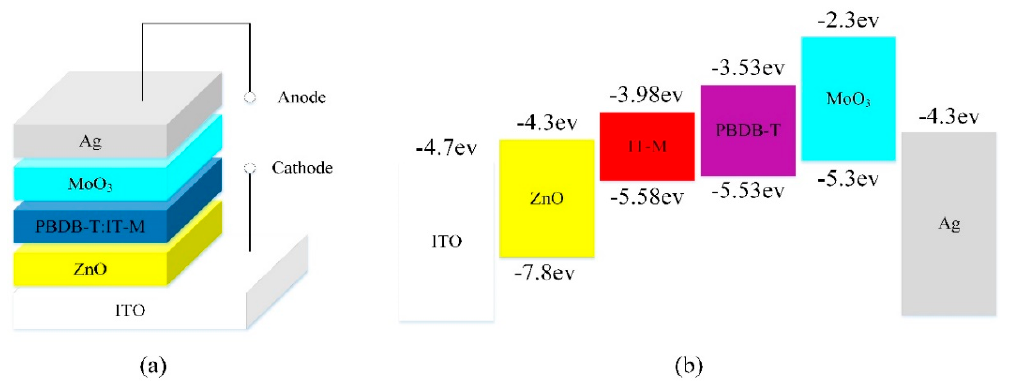
Figure 1. ( a ) Schematic device structures of inverted organic solar cells (OSCs); ( b ) energy level alignment of the components in the inverted OSCs with ZnO as the electron transport layer.